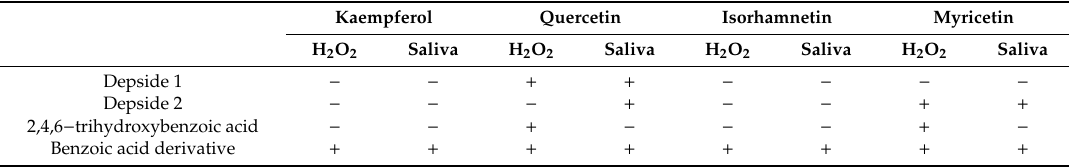
Figure 5. General scheme of flavonols’ degradation in the presence of saliva. Table 2. Comparison of products detected with H 2 O 2 and saliva